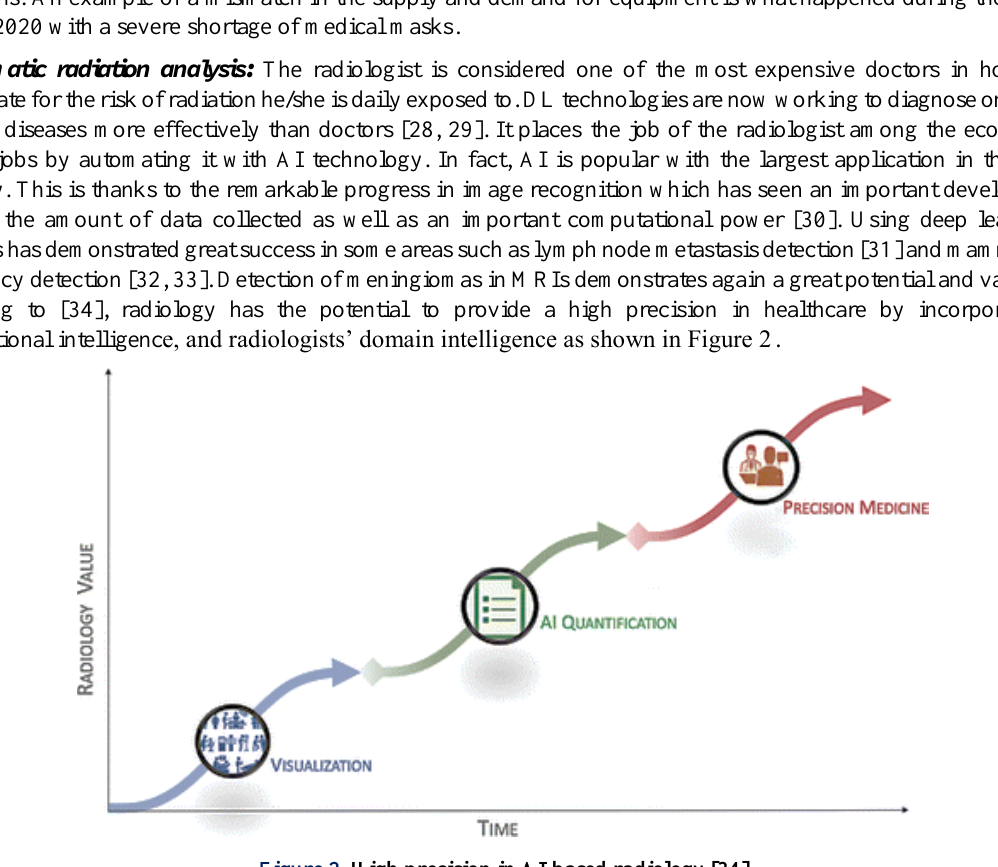
Figure 2. High precision in AI based radiology